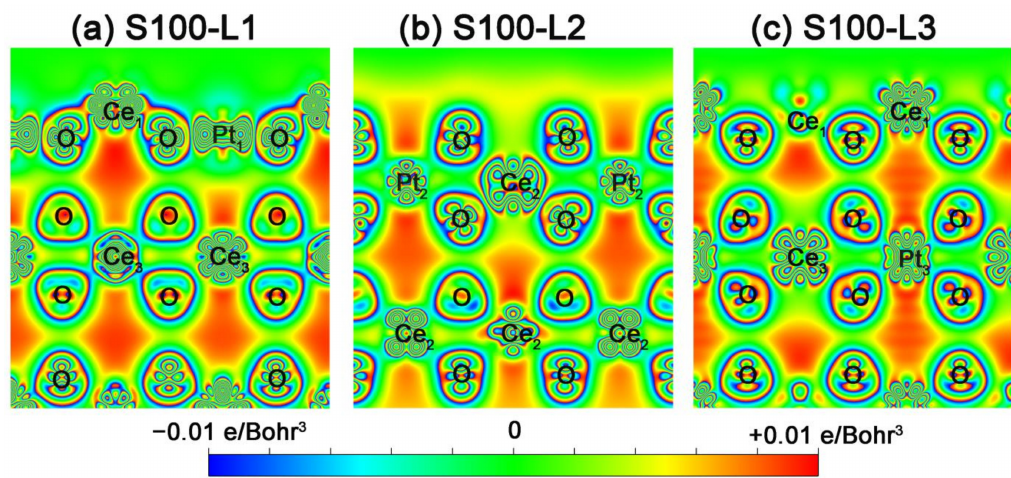
Figure 7. 2-D charge density difference plots along the (001)-direction ( ∆ n ( r ) in units of e /Bohr 3 ) for 1.5 × 1.5 × 1 Pt x Ce 1 − x O 2 -S100, which with Pt ( a ) on surface layer L1, ( b ) in second layer L2 and ( c ) in the “bulk” layer